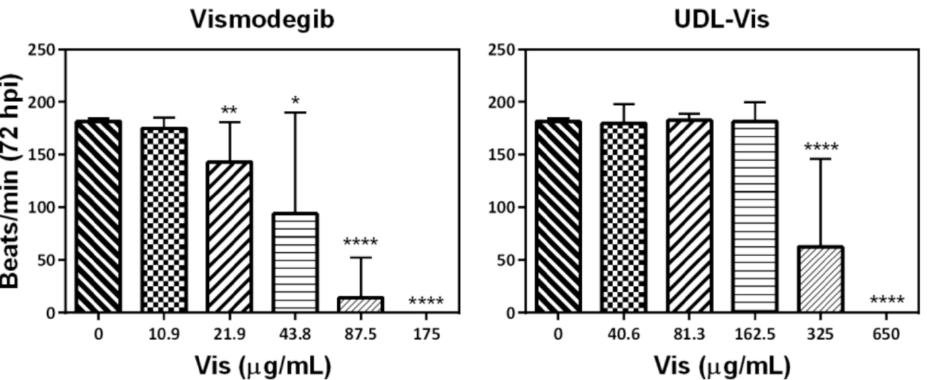
Figure 13. Heart rate of larvae at 72 h post-incubation (hpi) with free Vismodegib and UDL-Vis. Results are shown as mean ± SD ( n = 8). * p < 0.05, ** p < 0.01, **** p < 0.0001. Only one larva presented beats after incubation with 87.5 µ g/mL of the free drug (it showed bradycardia), and only four larvae presented beats (one of them showed tachy- cardia) after incubation with 43.8 µ g/mL of free Vismodegib. Besides this, larvae treated with 21.9 µ g/mL of free Vismodegib presented mostly bradycardia. For the case of larvae treated with 325 µ g/mL of UDL-Vis, only three larvae presented beats, and in all cases the heart rate corresponded to